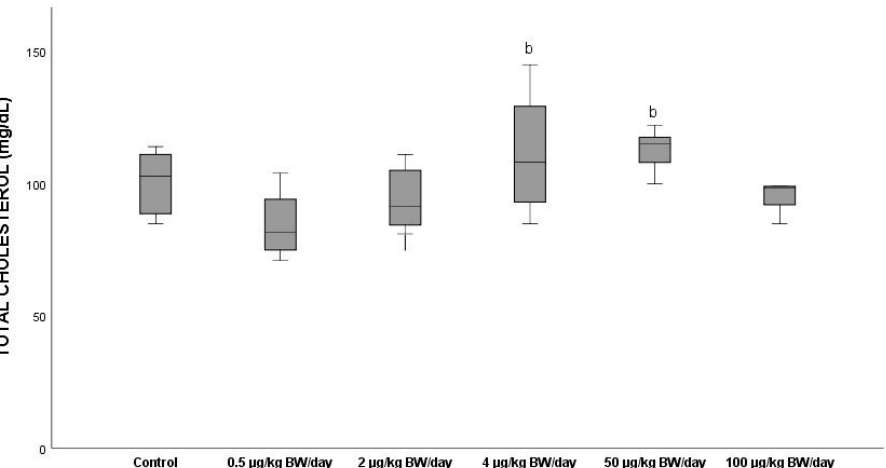
Figure 8. Means ± standard deviations of the serum levels of Total Cholesterol (TOT CHOL) expressed in mg/dL in the different exposure groups. b significant differences vs. 0.5 µ g/kg BW/day (G1).